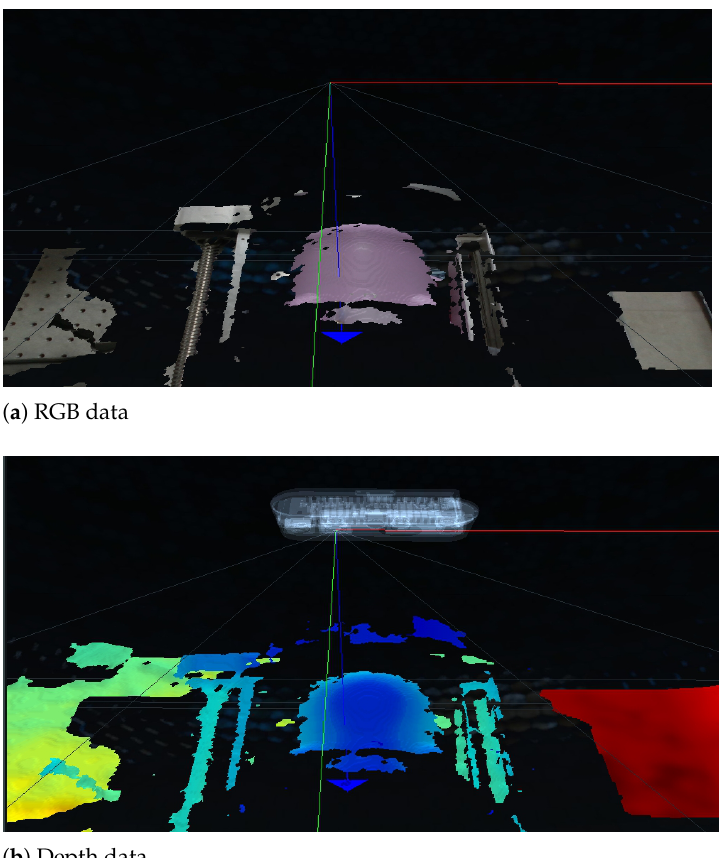
Figure 4. A point cloud example using an RGB-D camera and API